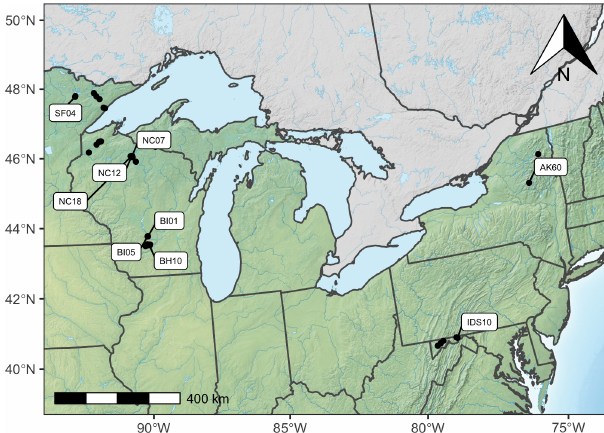
Figure 1. Map of sites used in this analysis. Sites shown in Fig. 6 are